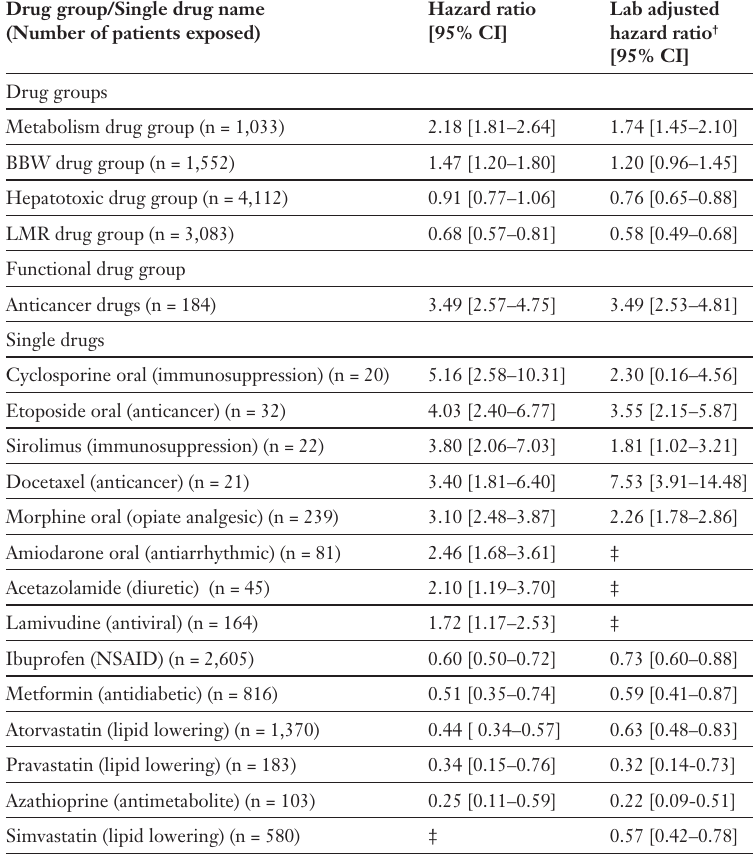
Hazard ratios for drug groups and single drugs. (all adjusted for age, cancer, liver diagnosis and race)* Drug group/Single drug name (Number of patients